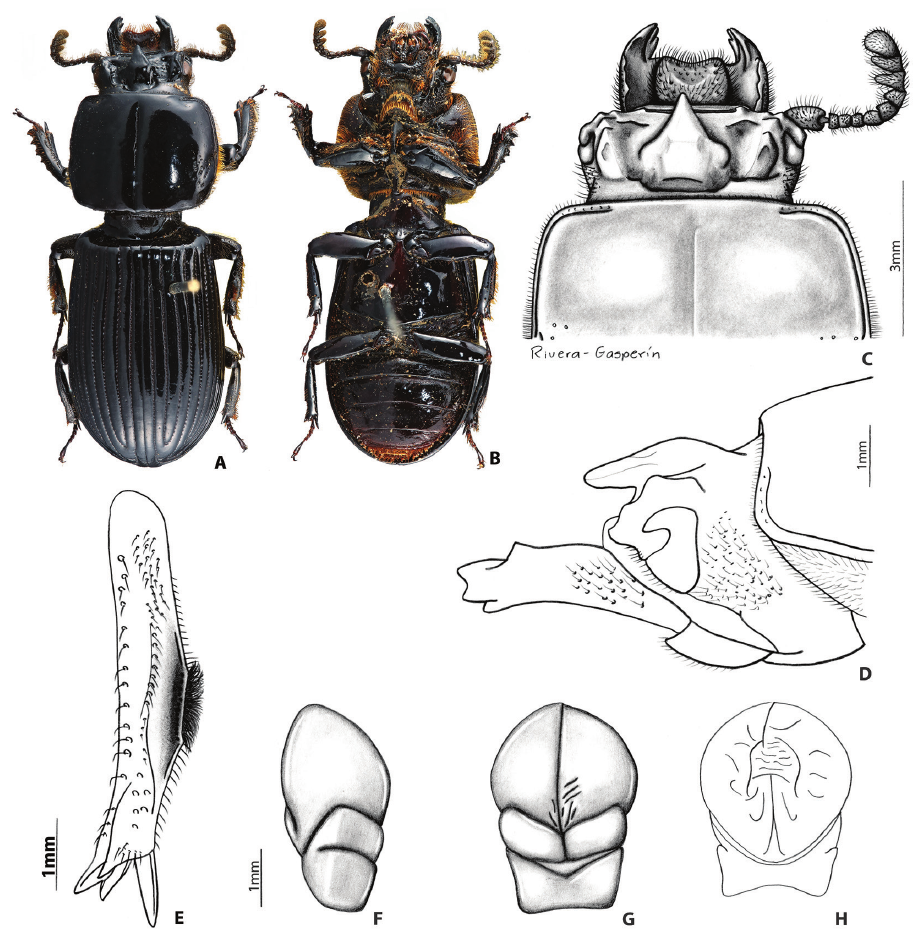
Figure 7. Yumtaax laticornis (Truqui) , holotype: A dorsal habitus B ventral habitus C dorsal view of pronotum and head D lateral view of pronotum and head E lateral view of right mesotibia F lateral view of aedeagus G ventral view of aedeagus H dorsal view of aedeagus. rounded weak, directed anteriorly. Frontal area: vertical, flat, smooth and shiny, frontal ridge absent. Frontal fossae: punctate and glabrous. Mesofrontal structure (MFS): of the “falsus” type (see Reyes-Castillo 1970); base subparallel and narrower than MFS’ lateral ridge; center horn long with apex acute, largely free and directed anteriorly (Fig. 7D), surpassing posterior margin of clypeus, dorsally without micro-punctures; base of center horn wide narrowing gradually until apex; dorsal fossa absent at the base of MFS. Occipital fossa: shallow posteriorly and deeper laterally, not connected with the frontal fossae. Posterior occipital sulcus concave. Supraorbital ridge: bituberculate, tubercles of similar size; posterior half of supraorbital ridge bifurcated. Canthus: with apex rounded, covering more than 1/3 of the eye, expanded distally. Eyes: